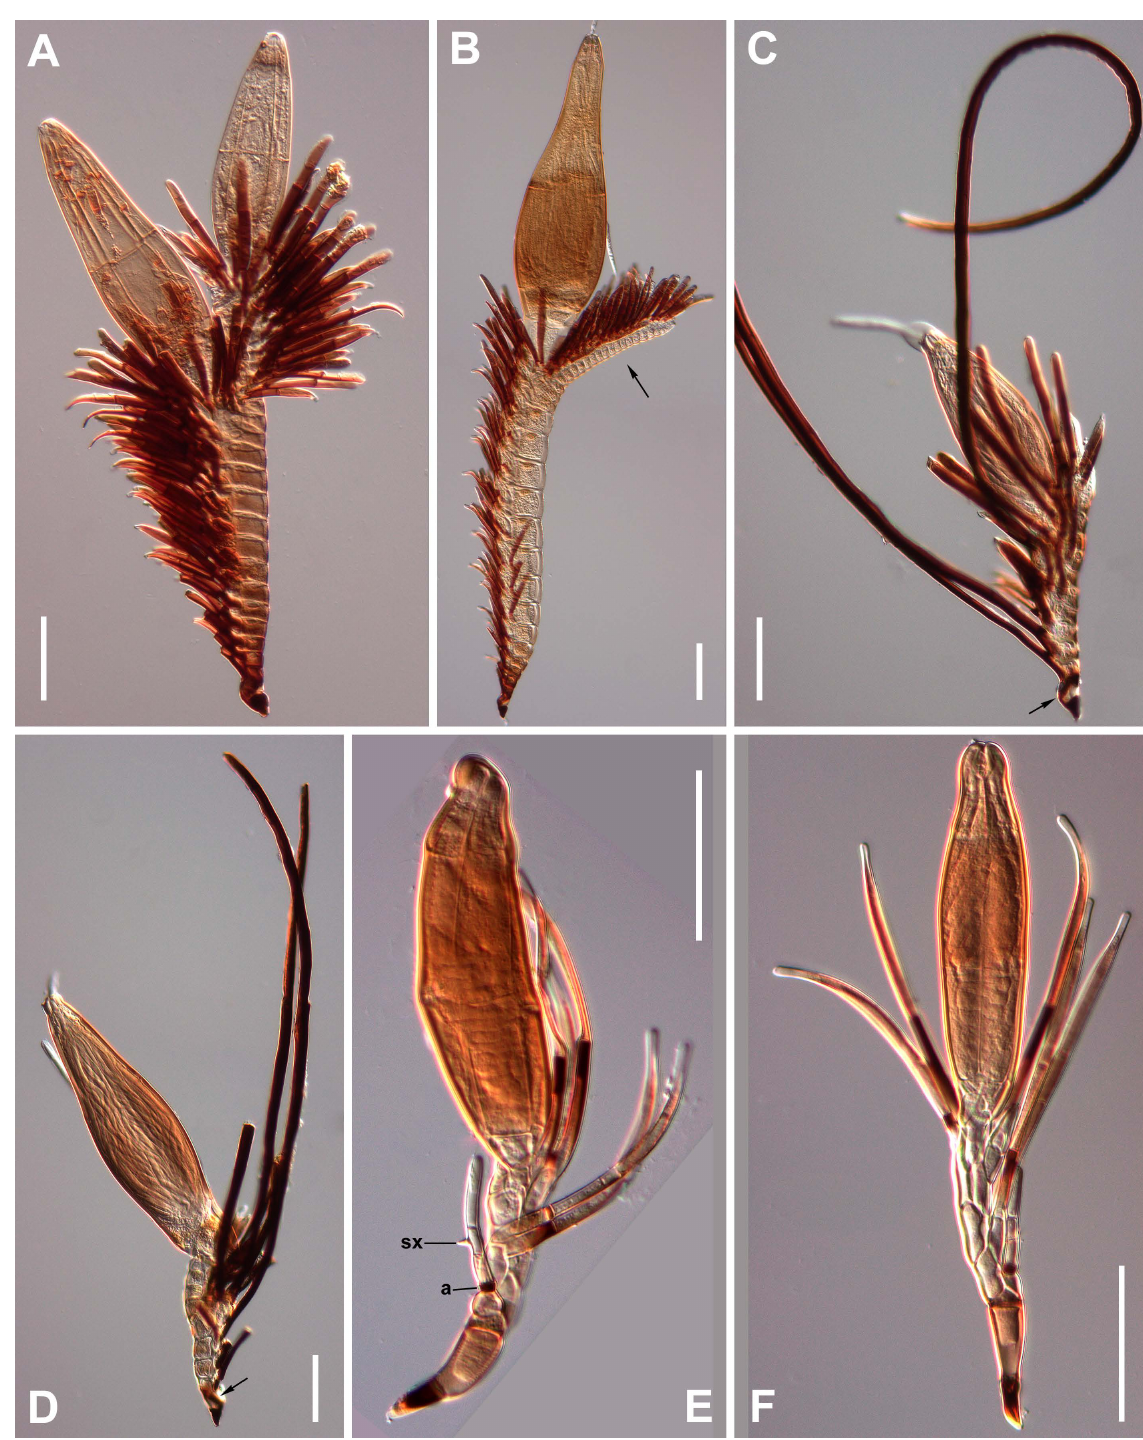
Fig. 18. Rhachomyces spp. A – B . R. philonthinus Thaxt. Mature thalli. In B, the lateral branch from the primary axis (a diagnostic character) is labelled (arrow). – C – D . R. pilosellus (C.P.Robin) Thaxt. Mature thalli with labelled blackened diagonal strip traversing cells I and II (arrows). – E – F . R. spinosus Santam. & Cuesta-Segura . Mature thalli. In E, primary septum (a) and spinous original spore apex (sx) are labelled. Scale bars: 50 µm. Photographs from slides ZMUC C-F-122681 (A), ZMUC C-F-122685 (B), ZMUC C-F-123833 (C–D), ZMUC C-F-123296 (E), ZMUC C-F-123062